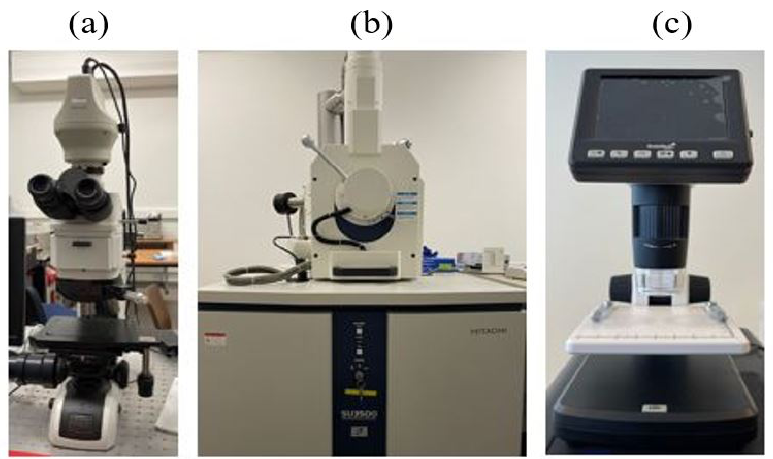
Figure 5. ( a ) Optical microscope; ( b ) scanning electron microscope; ( c ) digital